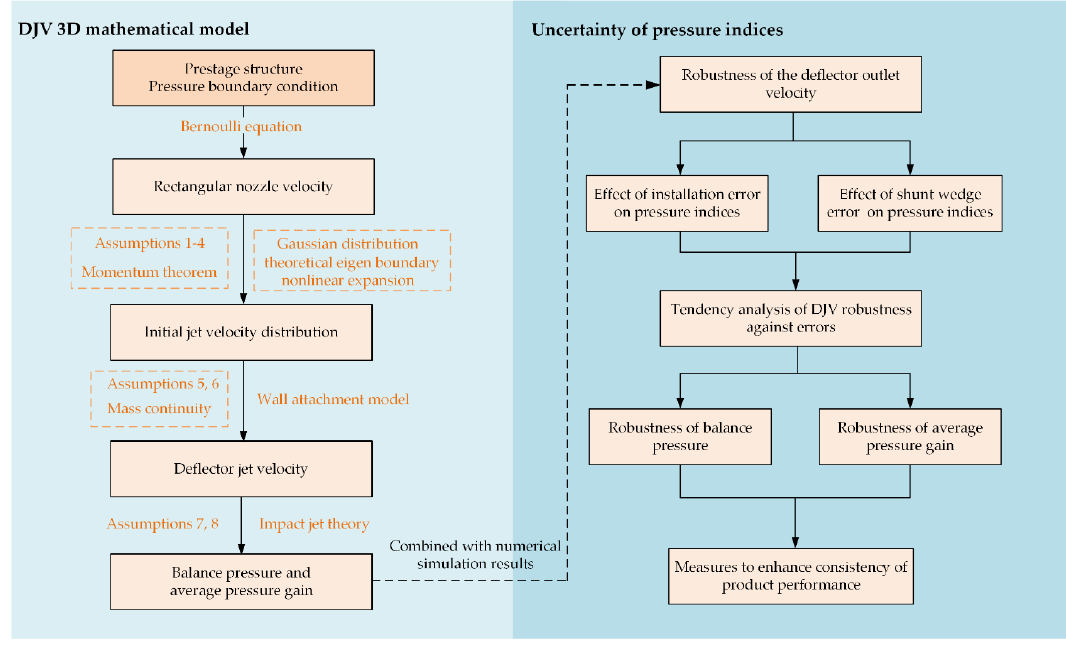
Figure 21. Flow charts of DJV three-dimensional mathematical model establishment and uncertainty analysis of pressure